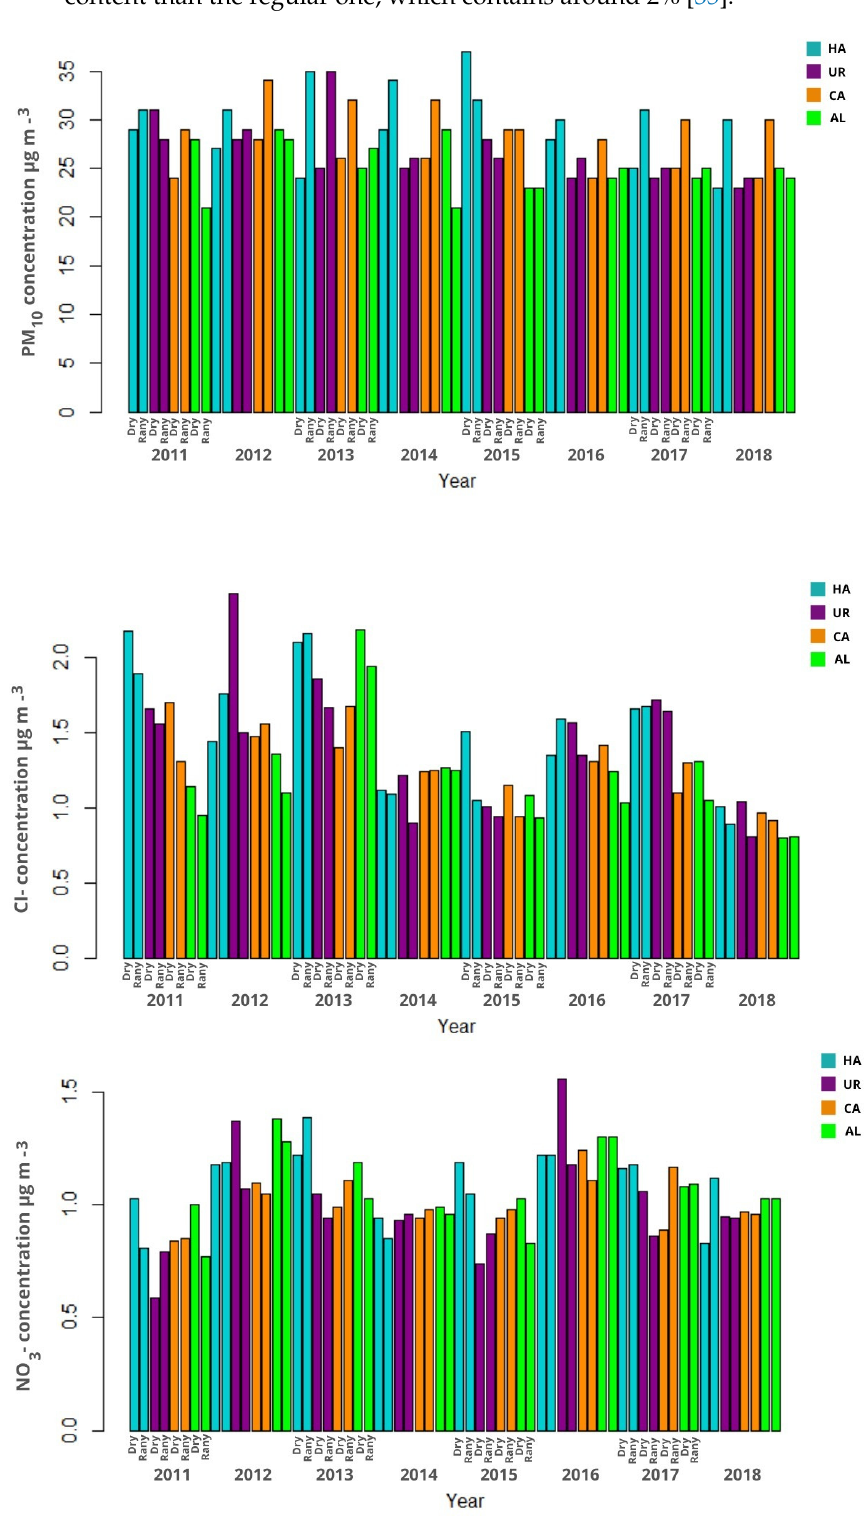
Figure 3. Temporal variations of PM 10 , Cl − , and NO 3 − concentration in each sampling site, 2011 − 2018.